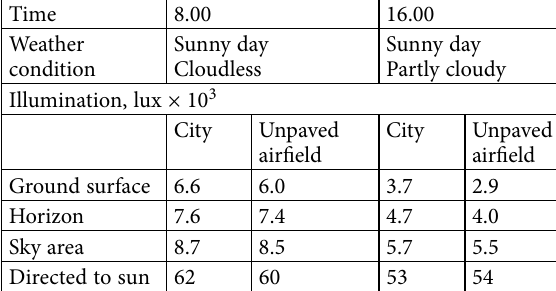
Fig. 4. Disposition of PD-1, PD-2, PD-3, PD-4